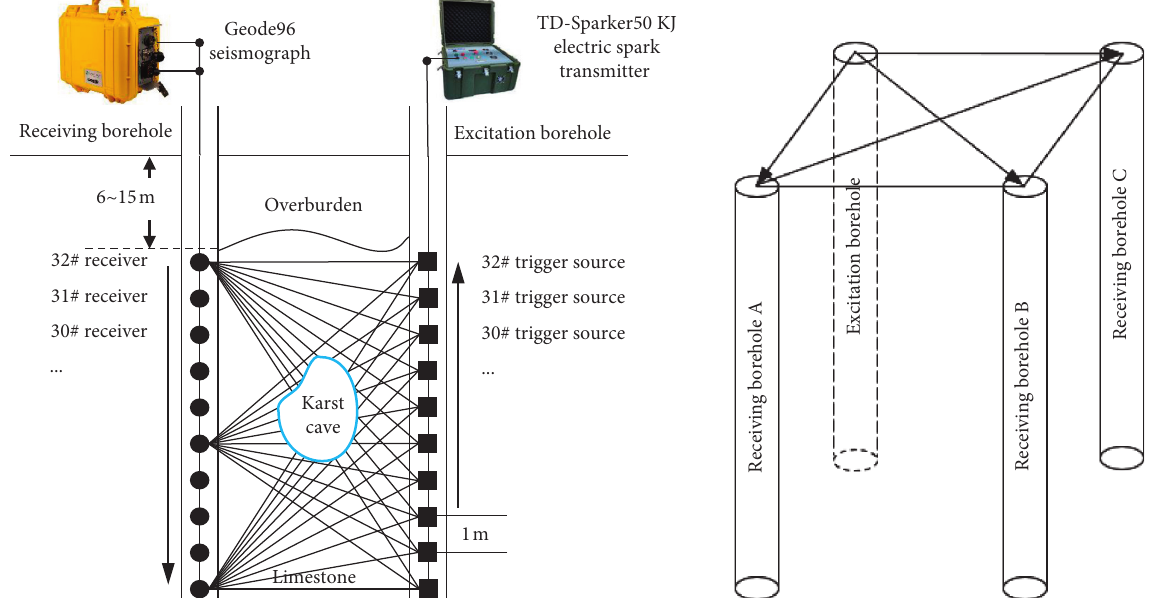
Figure 3: Schematic diagram of the detection system configuration and work principles of crosshole seismic CT.